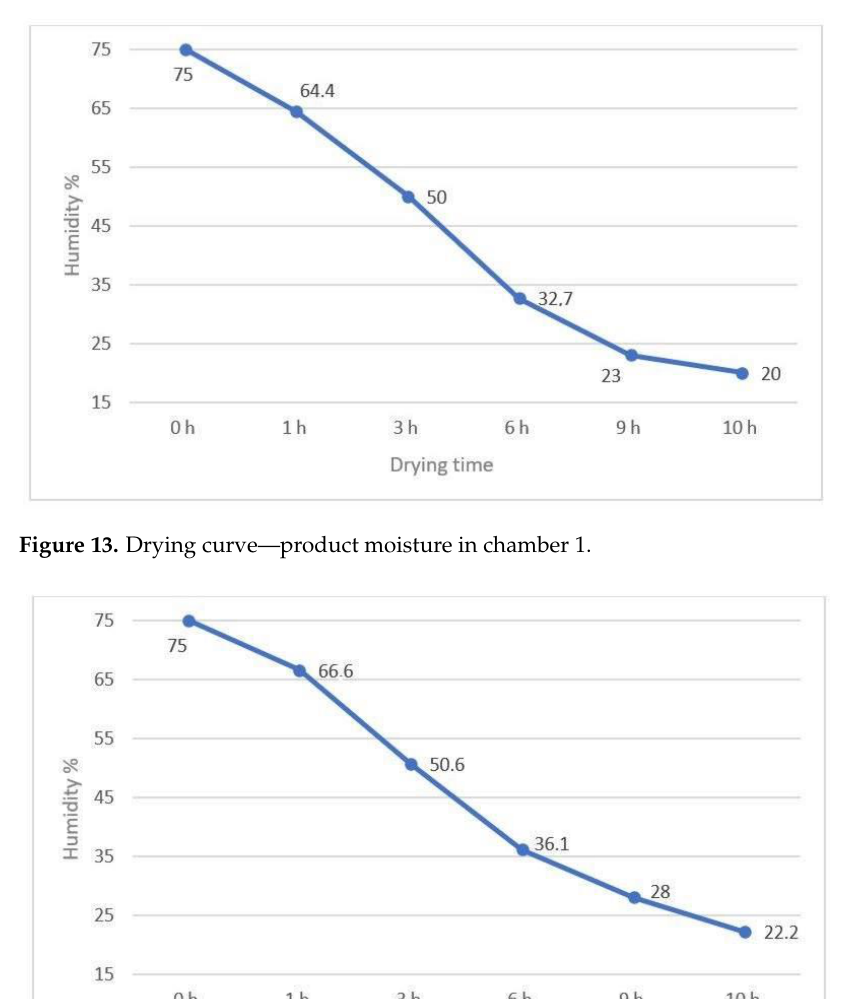
Figure 12. Changes in moisture content of beef samples taken from different zones of the drying chamber, chamber 5.